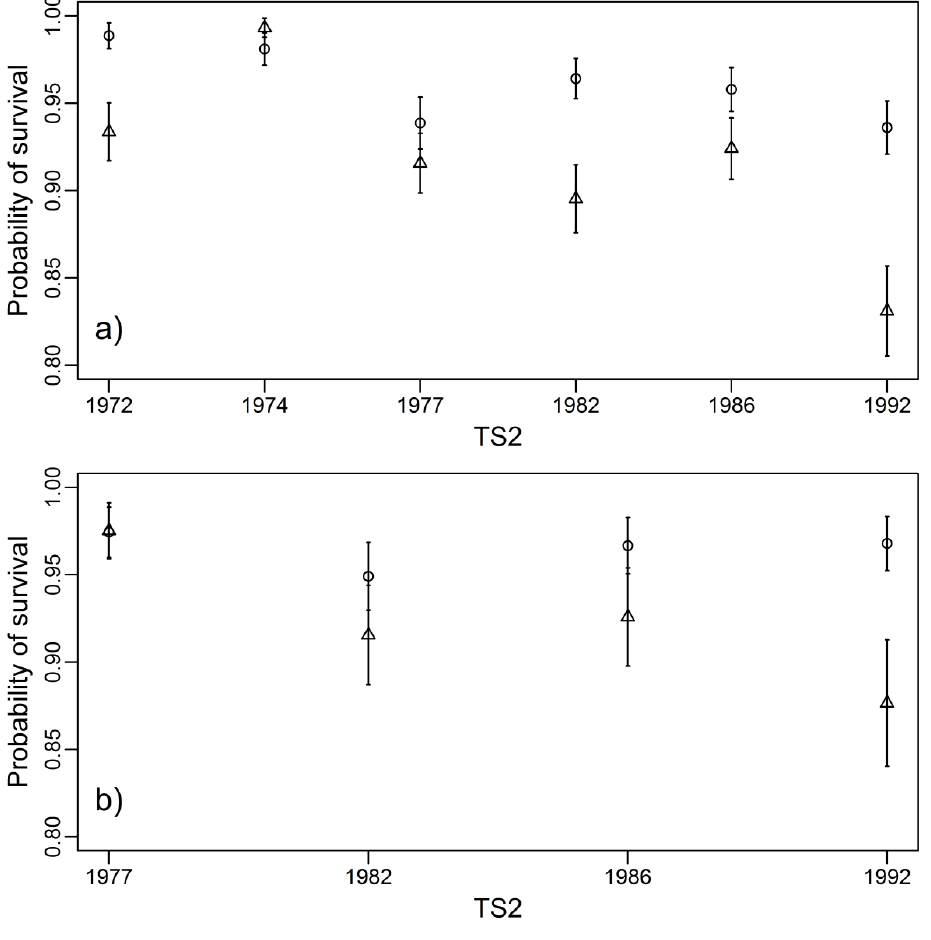
Figure 6. The proportion of trees surviving between survey periods. Overstorey species are shown in ( a ), and understorey species are shown in ( b ). Values on the x-axes show the timing of the second survey period (TS2). Error bars represent 95% confidence